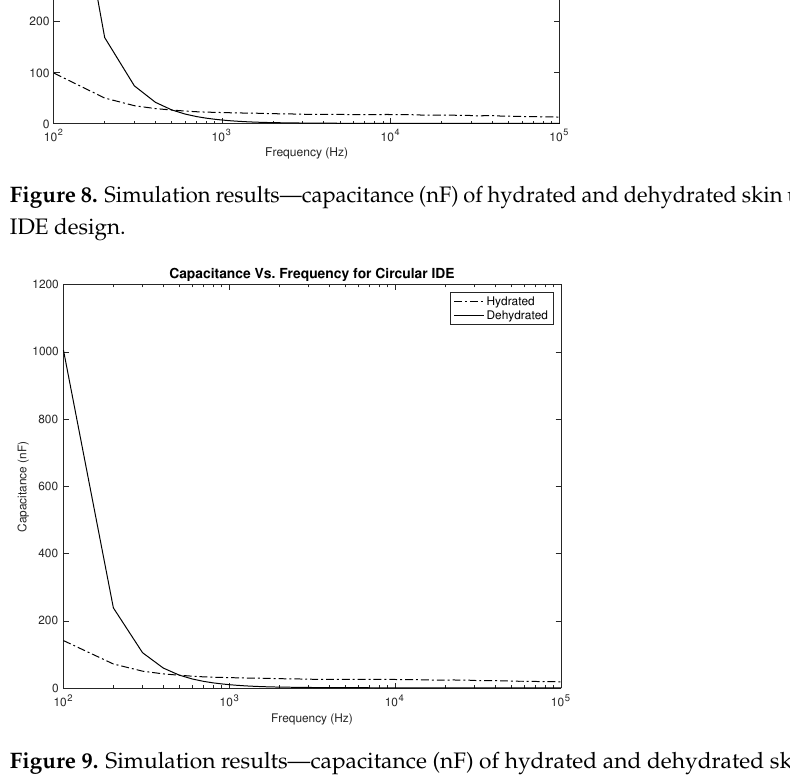
Figure 9. Simulation results—capacitance (nF) of hydrated and dehydrated skin using the circular IDE